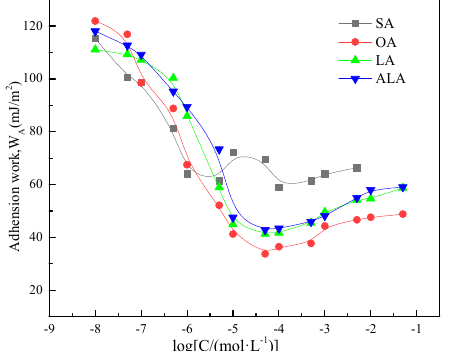
Figure 8. Variation of W A with fatty acid concentration.